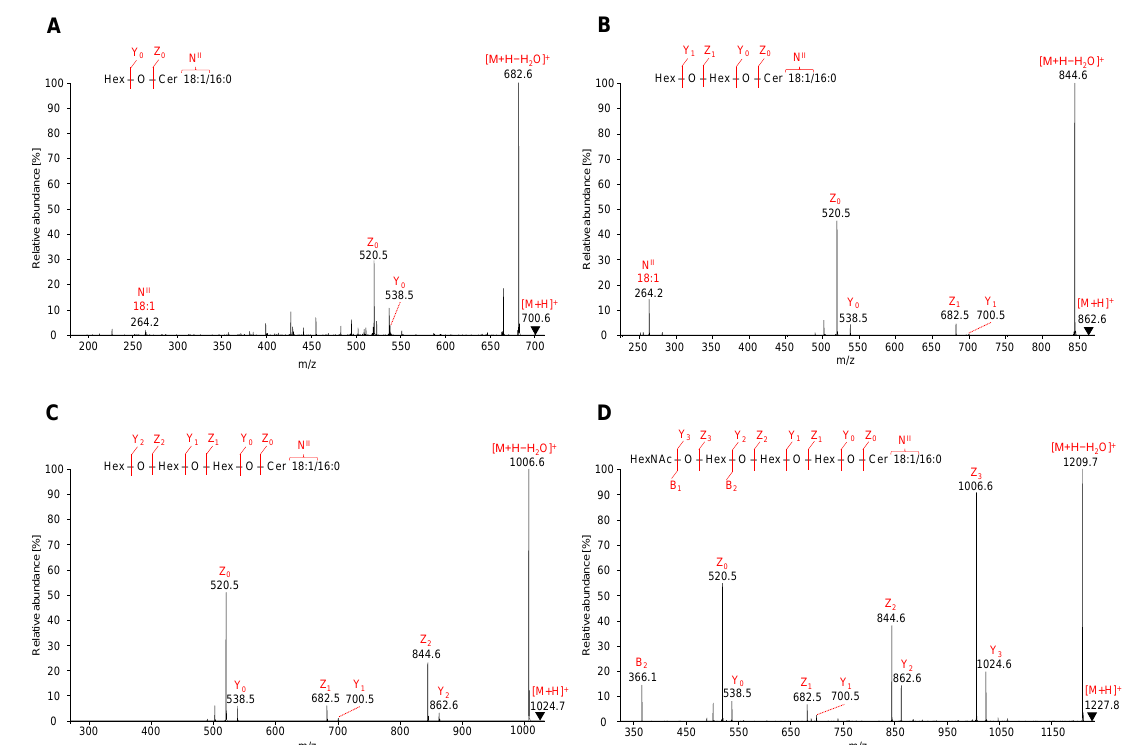
Figure 5. HILIC-ESI-MS/MS spectra of representative neutral GSL species. Tandem mass spectrometry (MS/MS) spectra illustrate fragmentation pathways with specific product ions of ( A ) HexCer 18:1/16:0 at m/z 700.6, ( B ) Hex 2 Cer 18:1/16:0 at m/z 862.6, ( C ) Gb 3 18:1/16:0 at m/z 1024.7, and ( D ) Gb 4 18:1/16:0 at m/z 1227.8. MS/MS spectra of HexCer, 18:1/16:0, Hex 2 Cer, 18:1/16:0, Gb 3 , 18:1/16:0, and Gb 4 , 18:1/16:0 were characterized by the fragmentation of precursor ions [M+H] + identified as m/z 700.6 for HexCer (Figure 5A), m/z 862.6 for Hex 2 Cer (Figure 5B), m/z 1024.7 for